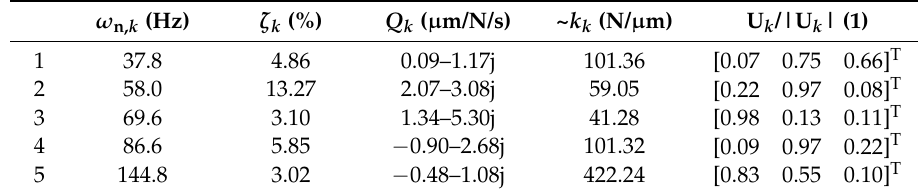
Table 1. Modal parameters at L = 400 mm ram